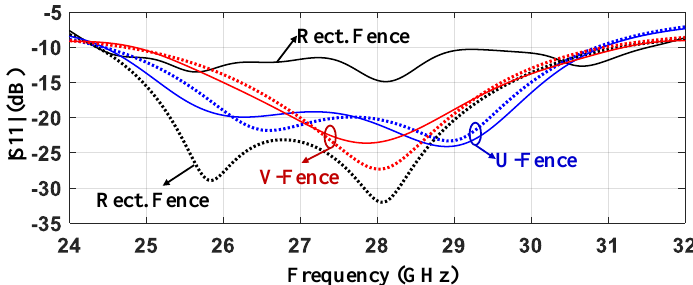
Figure 9. The measured (solid line) and simulated (dotted line) S11 plots for the single element dipoles.